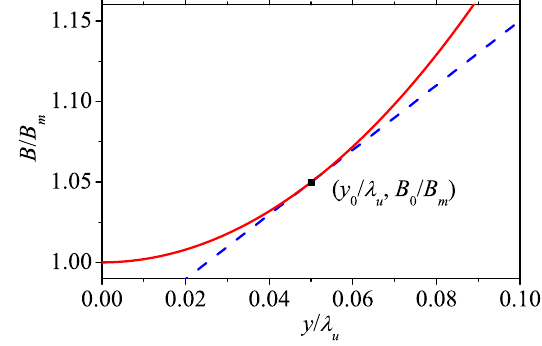
FIG. 2. The variation of the undulator peak field in vertical direction (solid red) and an example of linearly differential approximation (dashed